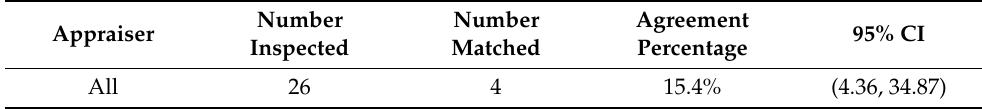
Table A5. Inspection System Accuracy (All Appraisers vs. Ground